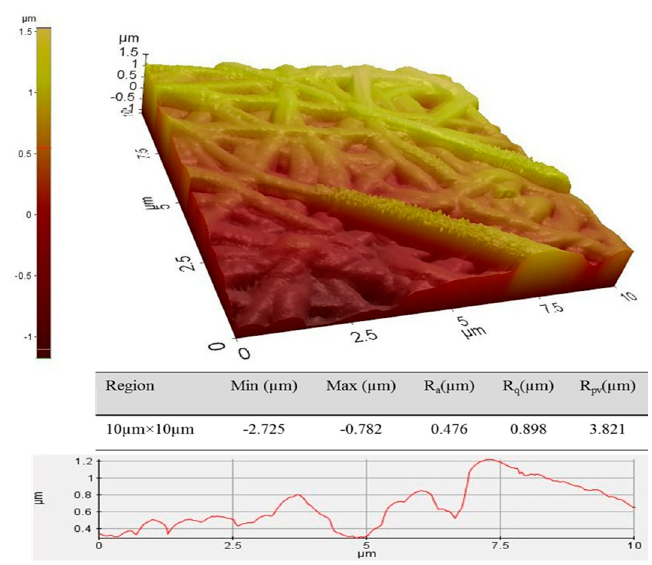
Figure 7. 3D surface micrograph of TPU/PLLA- γ -Fe 2 O 3 surface roughness.